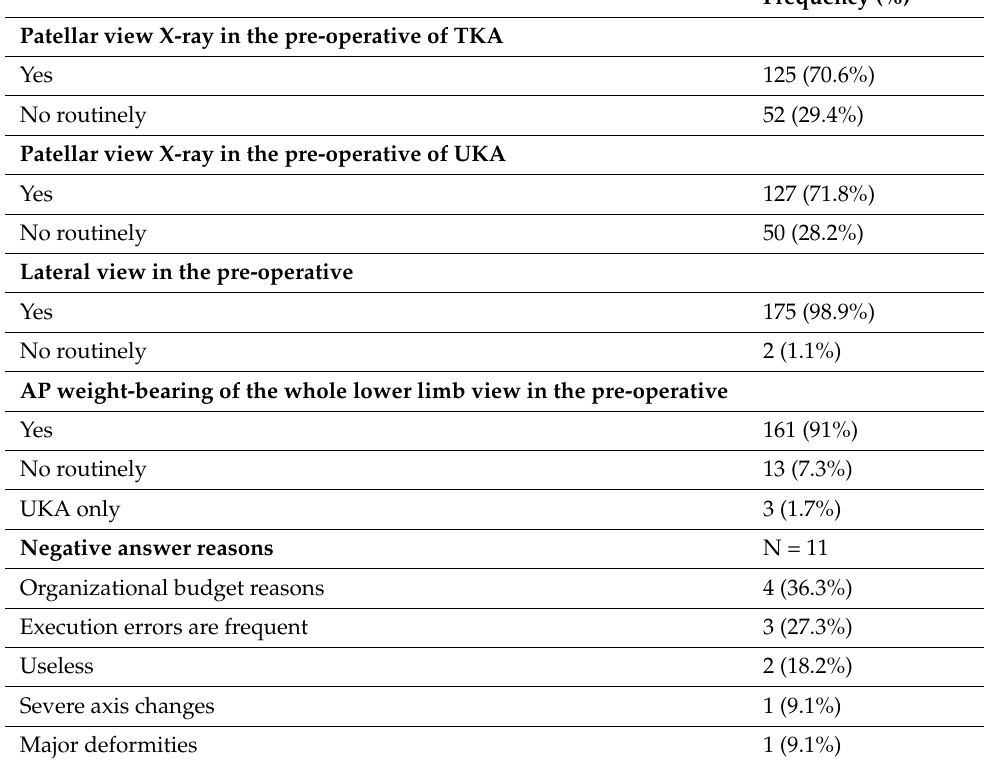
Table 4. Radiographic pre-operative data.